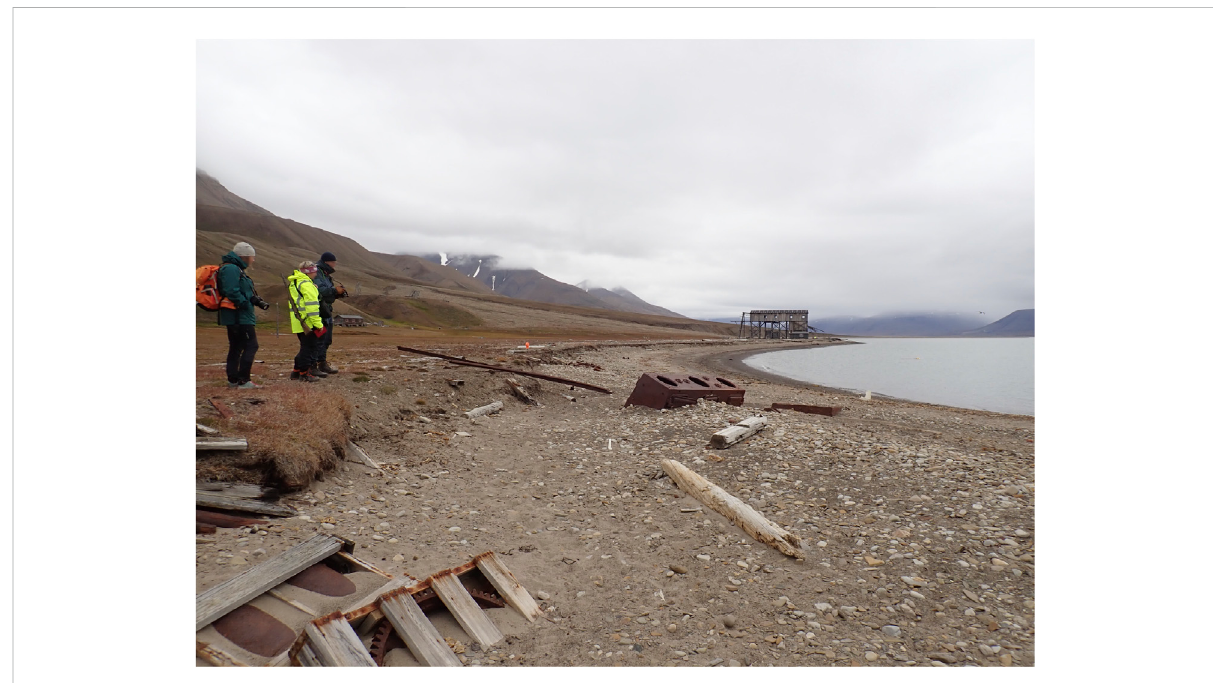
FIGURE 3 The beach at Hiorthhamn, Svalbard, with remains of steam engine and rails on beach. Photo: Vibeke Vandrup Martens, NIKU 2019.